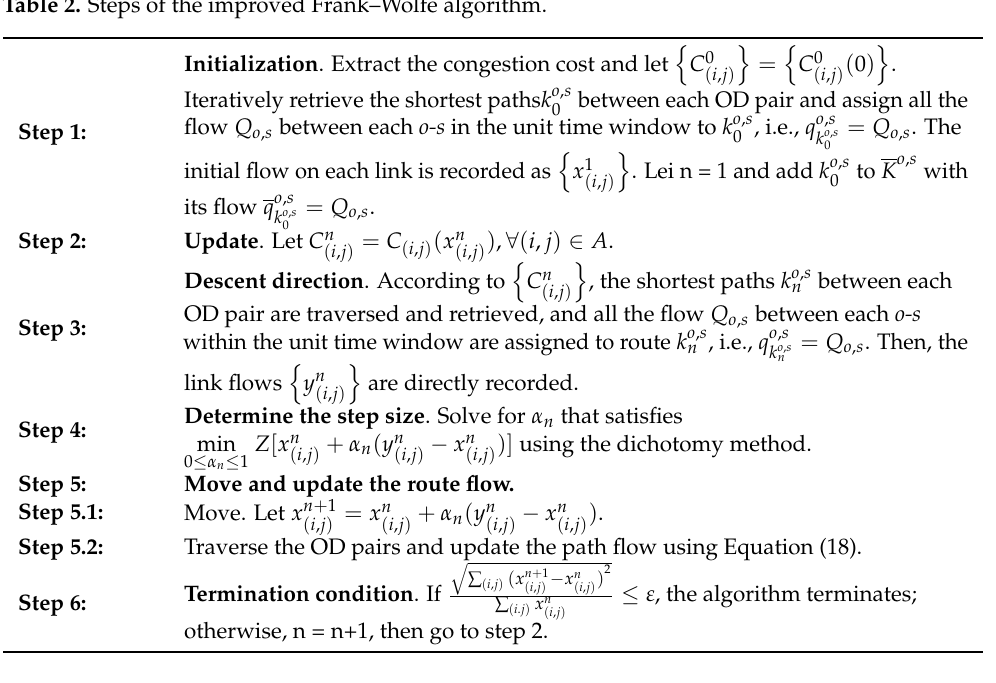
Table 2. Steps of the improved Frank–Wolfe